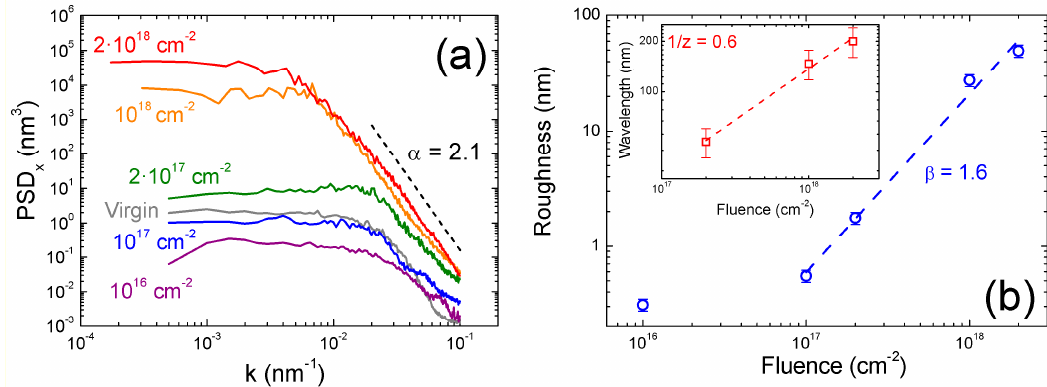
Figure 2. ( a ) Power spectral density (PSD) functions obtained along the x-axis (for the virgin and low fluence irradiated surfaces) and along the perpendicular direction of the ripple pattern (for the higher fluences). The dashed line indicates the linear regime for the high k range. From its slope, a value of the exponent α = 2.1 is obtained. ( b ) Logarithmic plot of the surface roughness versus the fluence. The dashed line corresponds to the power law dependence observed with exponent β = 1.6. Inset: logarithmic plot of the pattern wavelength for the three samples displaying a ripple pattern. The dashed line corresponds to the power law dependence with a coarsening exponent 1/z = 0.6.